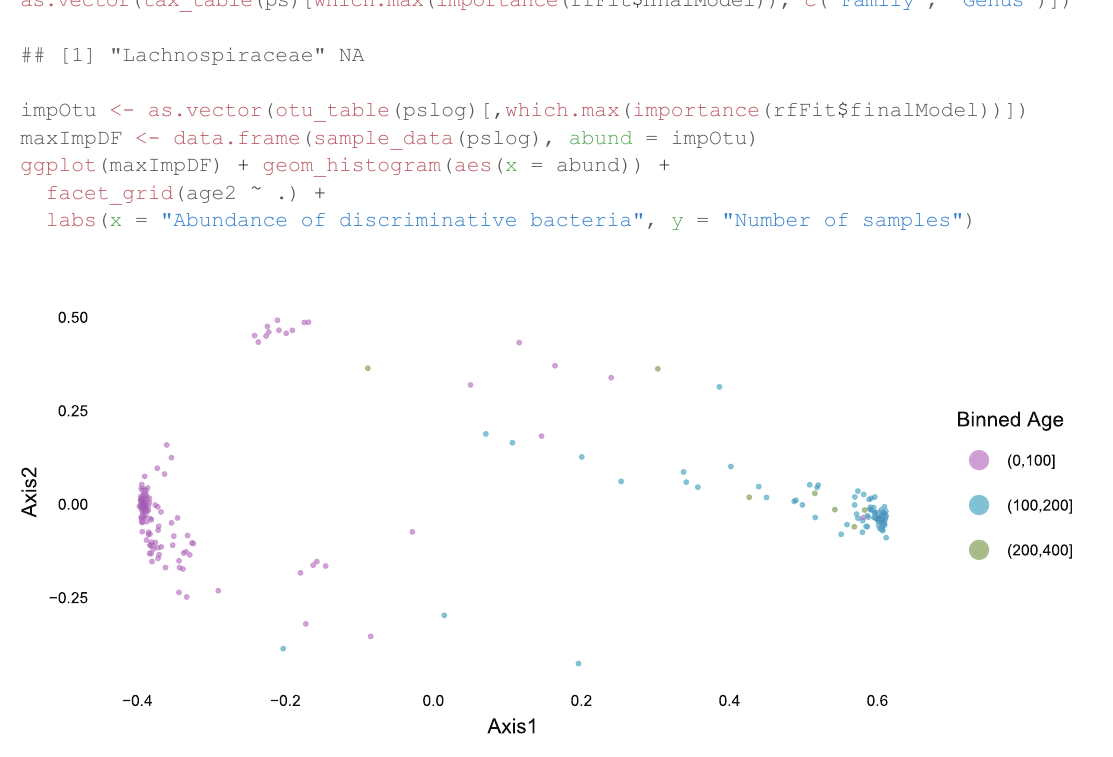
Figure 20. The random forest model determines a distance between samples, which can be input into PCoA to produce a proximity plot.